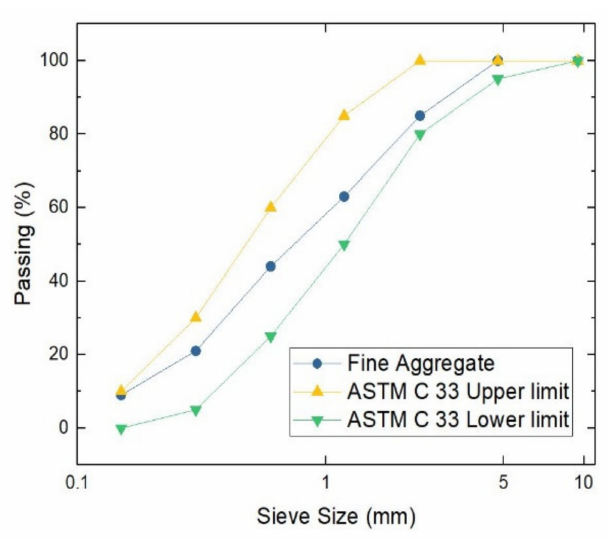
Figure 2. Grading curve of the fine aggregate.